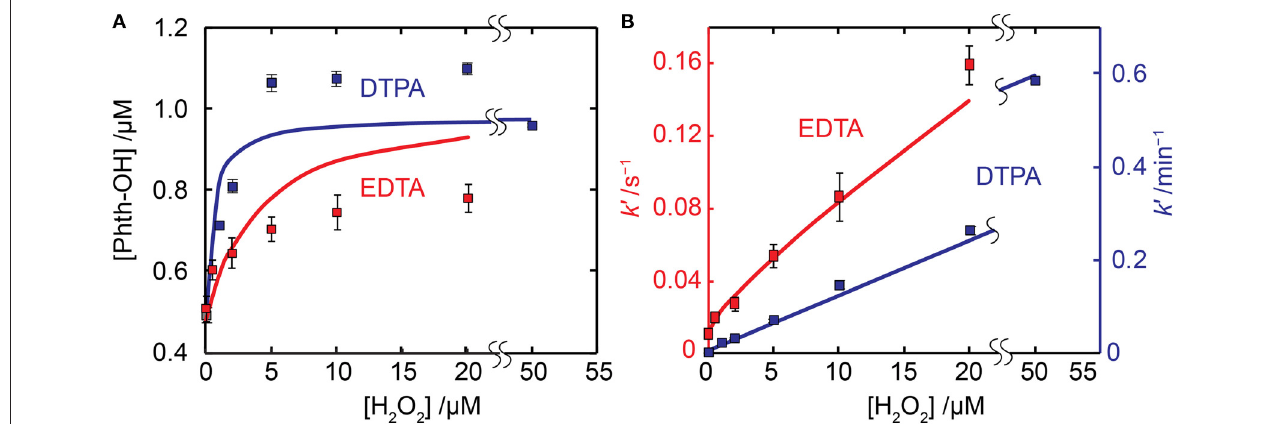
FIGURE 2 | Comparison of experimental and model results for the magnitude (A) and pseudo-first order rate constant (B) of Phth-OH production for L = EDTA and DTPA. Experimental data are shown as symbols in all panels with the model results shown as solid lines. In all cases [Fe(II)] 0 = 2 µ M and [L] = 10 µ M.